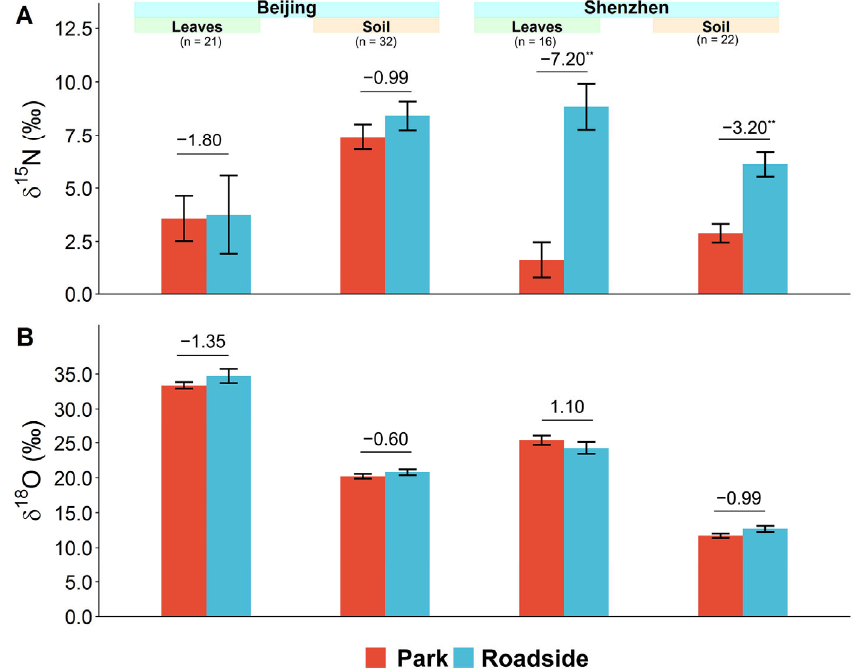
Figure 2. Differences in stable isotopic compositions (( A ) δ 15 N and ( B ) δ 18 O) of urban trees in the green lands (Note: The numbers and asterisk above the bars indicate the mean value differences. Significance of differences: ** for p < 0.01. Error bars indicate the 95% confidence interval of the means).